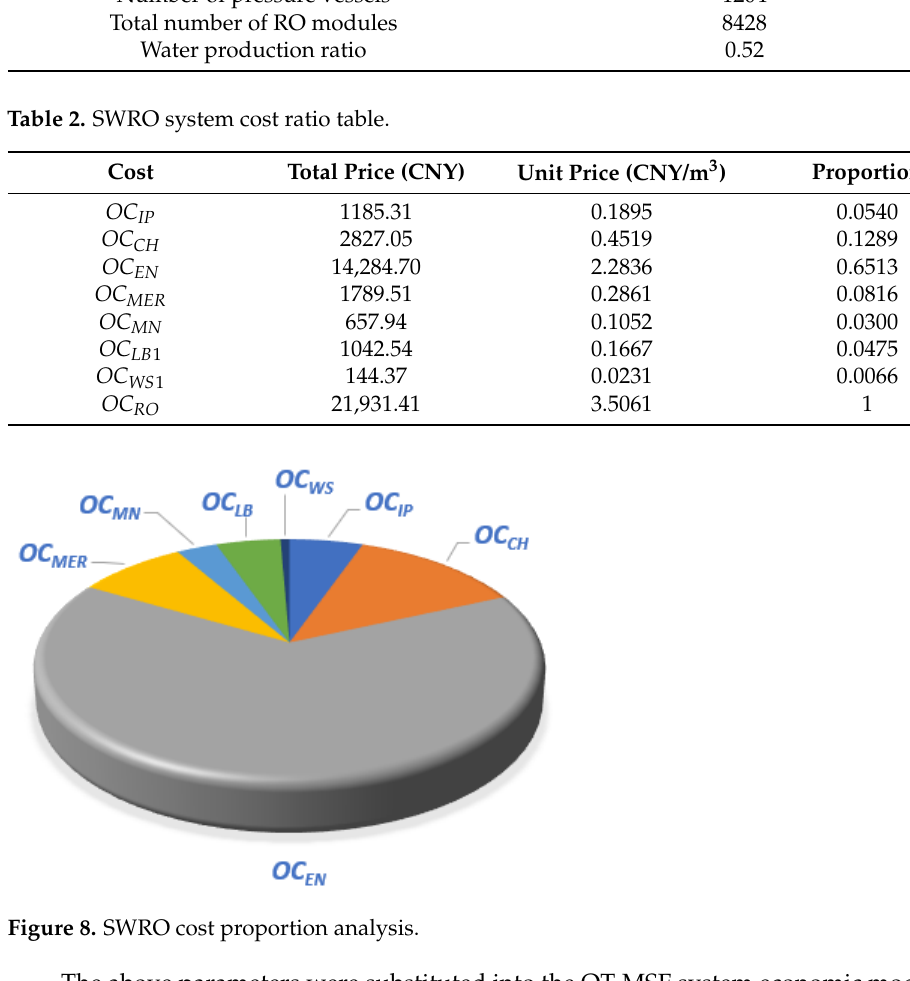
Table 3. Water production of the OT-MSF